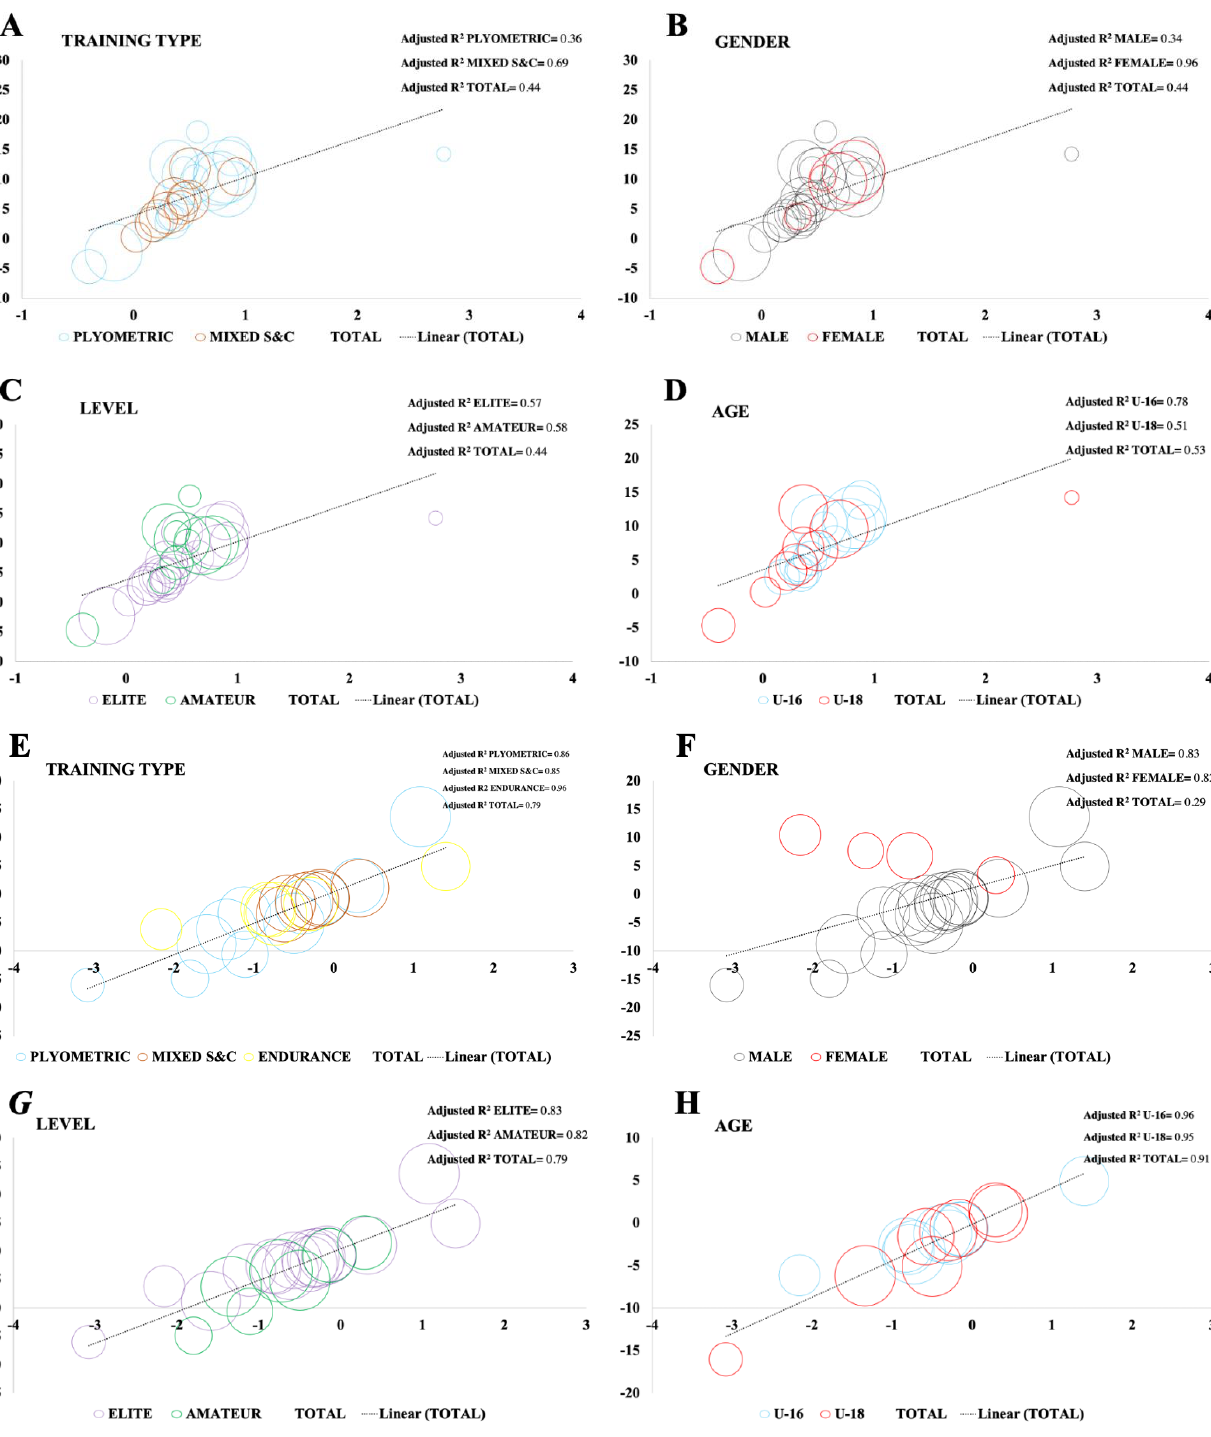
horizontal ( E – H ) groups: training type ( A ), gender ( B ), level ( C ) and age ( D ) and neuromuscular power considering sub-groups: training type ( E ), gender ( F ) , level ( G ) and age ( H ).